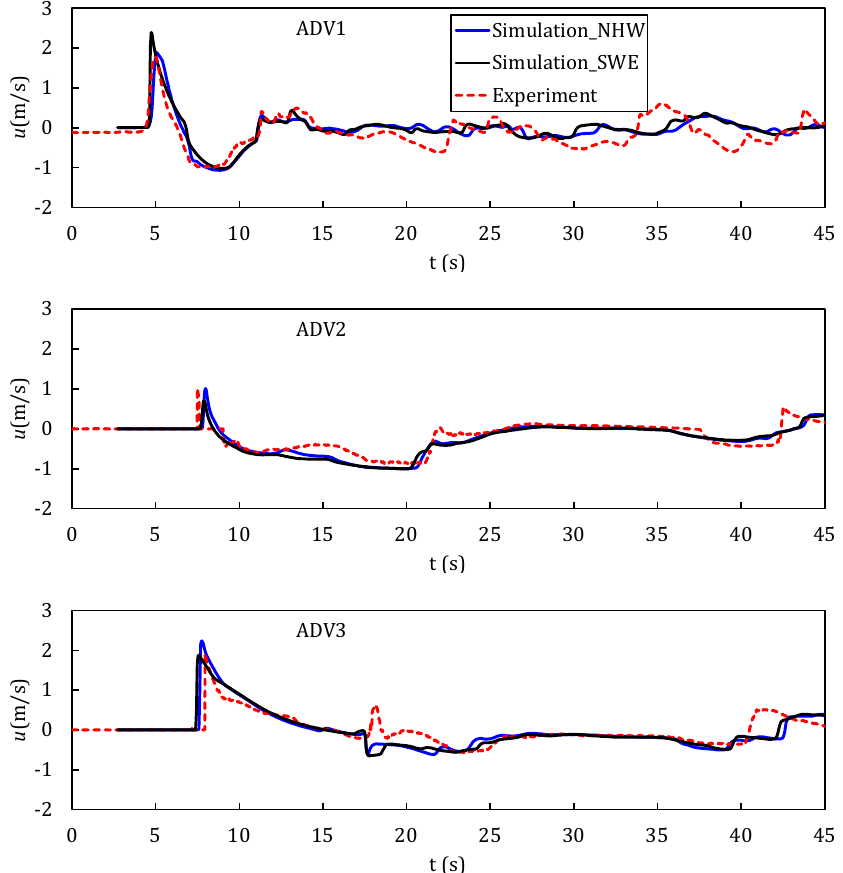
Figure 17. Comparisons of temporal velocity variations at the x direction for breaking and runup of a solitary wave over a three-dimensional complex